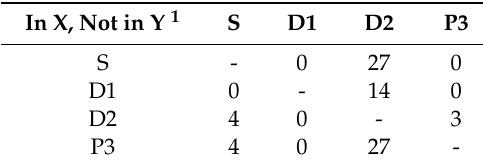
Table 2. Fixed derived SNPs in the sequenced duplicated region at locus X, rows, not segregating at locus Y, columns.